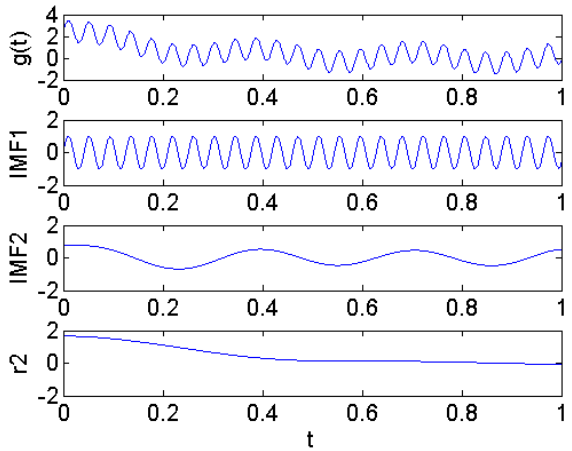
Figure 2. A function g ( t ) and its intrinsic mode functions ( IMF function ( r 2